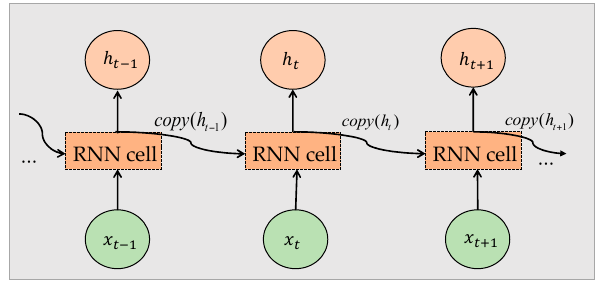
Figure 2. The expanded structure of recurrent neural network (RNN).